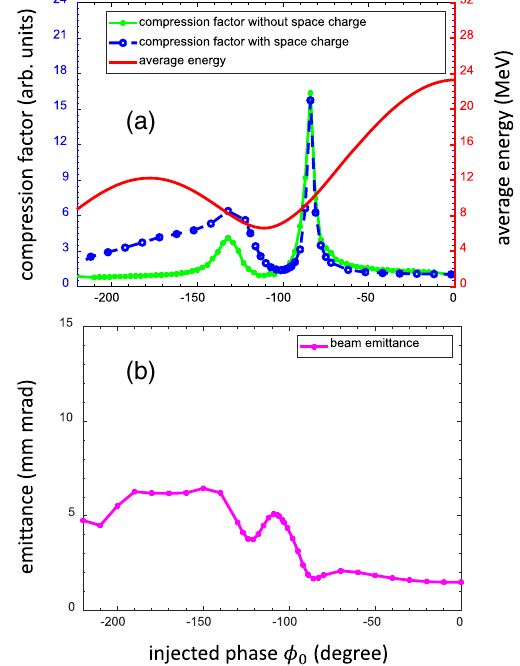
FIG. 6. Simulation results for single-bunch compression: (a) compression factors (with and without a space charge effect) and average beam energy versus the injected phase ϕ 0 and (b) beam emittance versus the injected phase ϕ 0 .